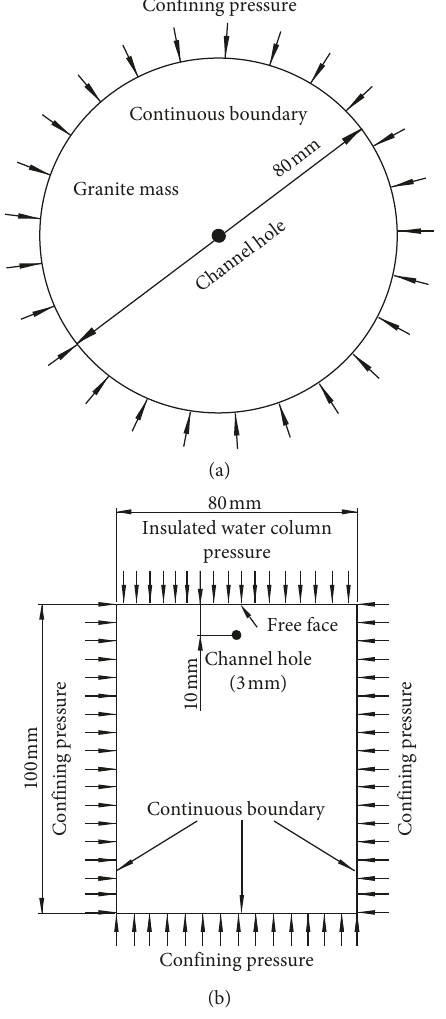
Figure 6: Models of EPB in granite under confining pressure: (a) Surface damage and (b) internal